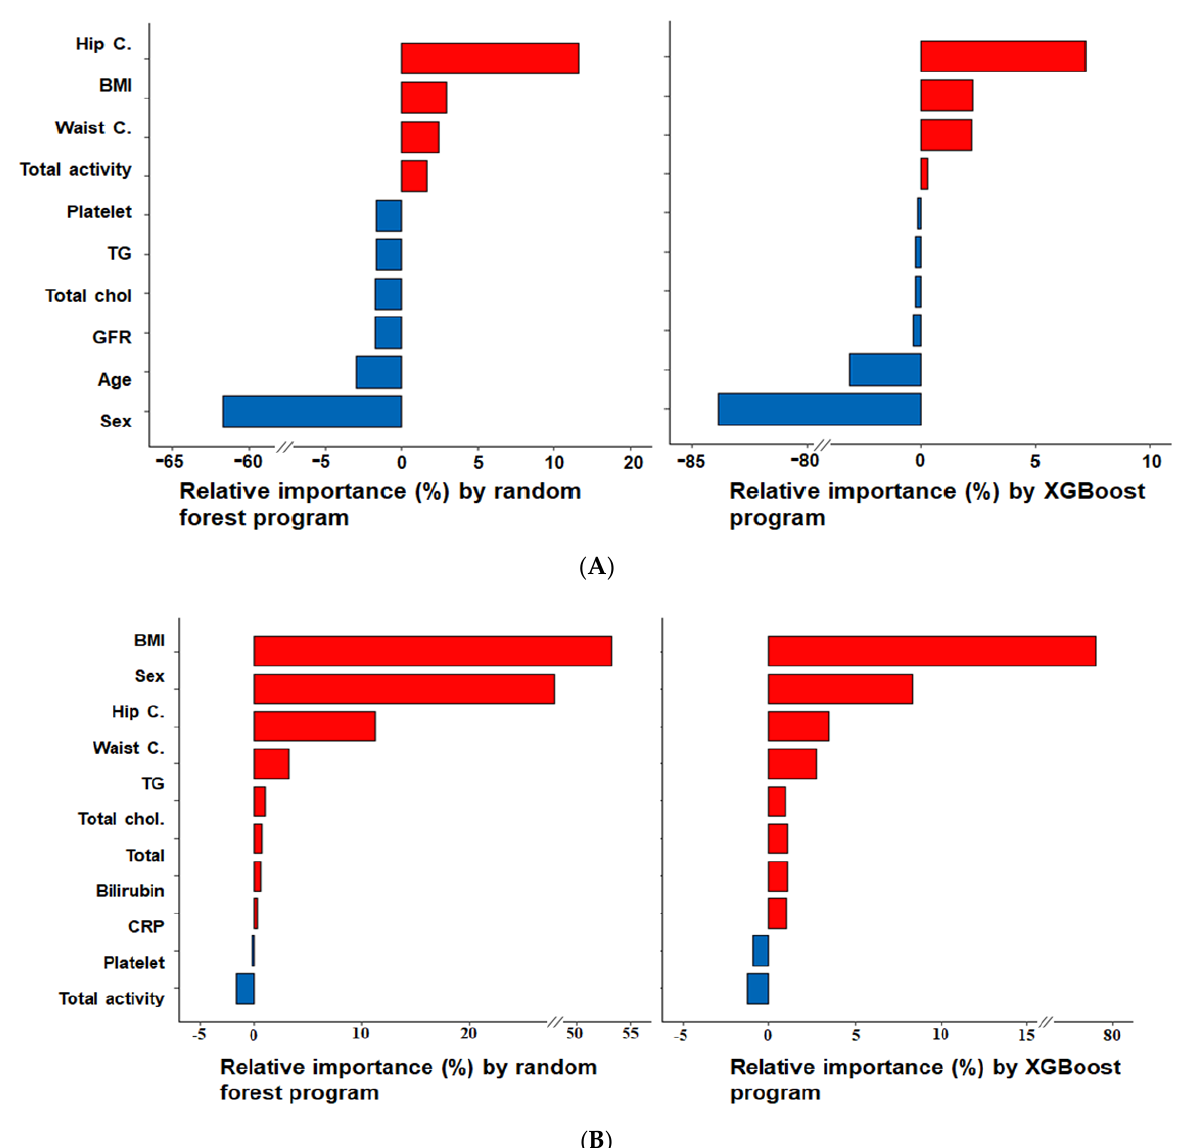
Figure 2. The relative importance of variables for predicting SMM and FM, as determined by the random forest and XGBoost algorithm. ( A ) Skeletal muscle mass (SMM); ( B ) fat mass (FM). BMI, body mass index; C., circumferences; GFR, glomerular filtration rate; Total chol., serum total cholesterol concentrations; TG, serum triglyceride concentrations.